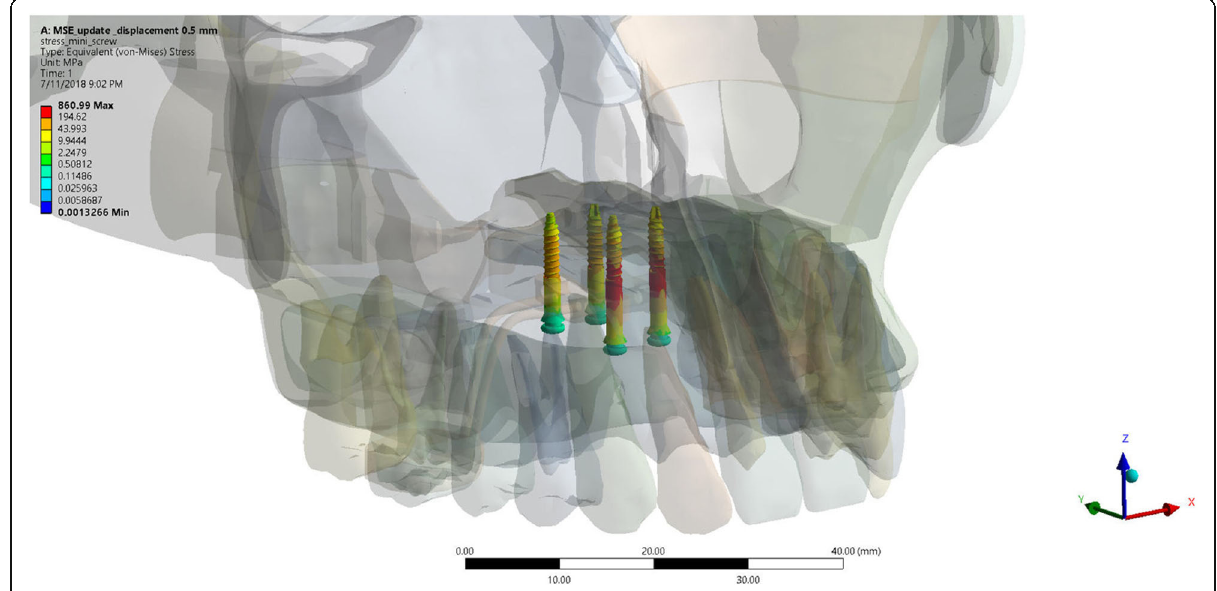
Fig. 5 The stress distribution of the miniscrew in the expansion simulation using